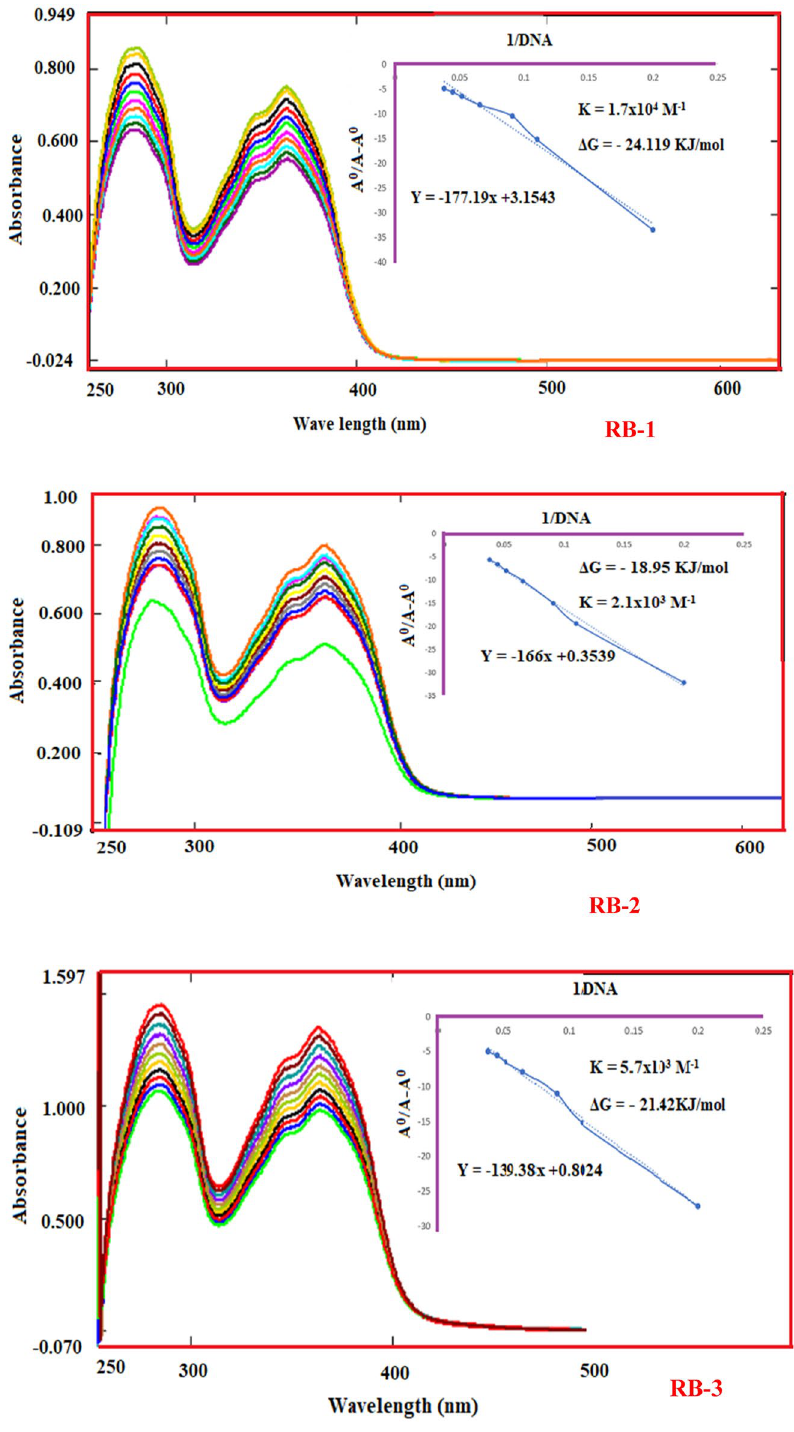
Figure 5. Absorption spectra of RB-1, RB-2 and RB-3 with SS-DNA and graph between A 0 /A-A 0 vs 1/DNA showing binding constant by the interaction between SS-DNA and the corresponding